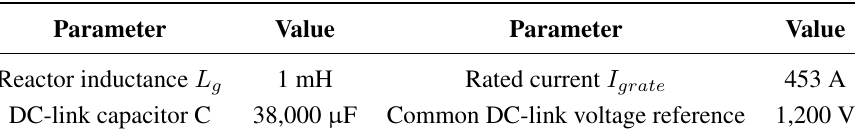
Table 2. Grid-side converter parameters.